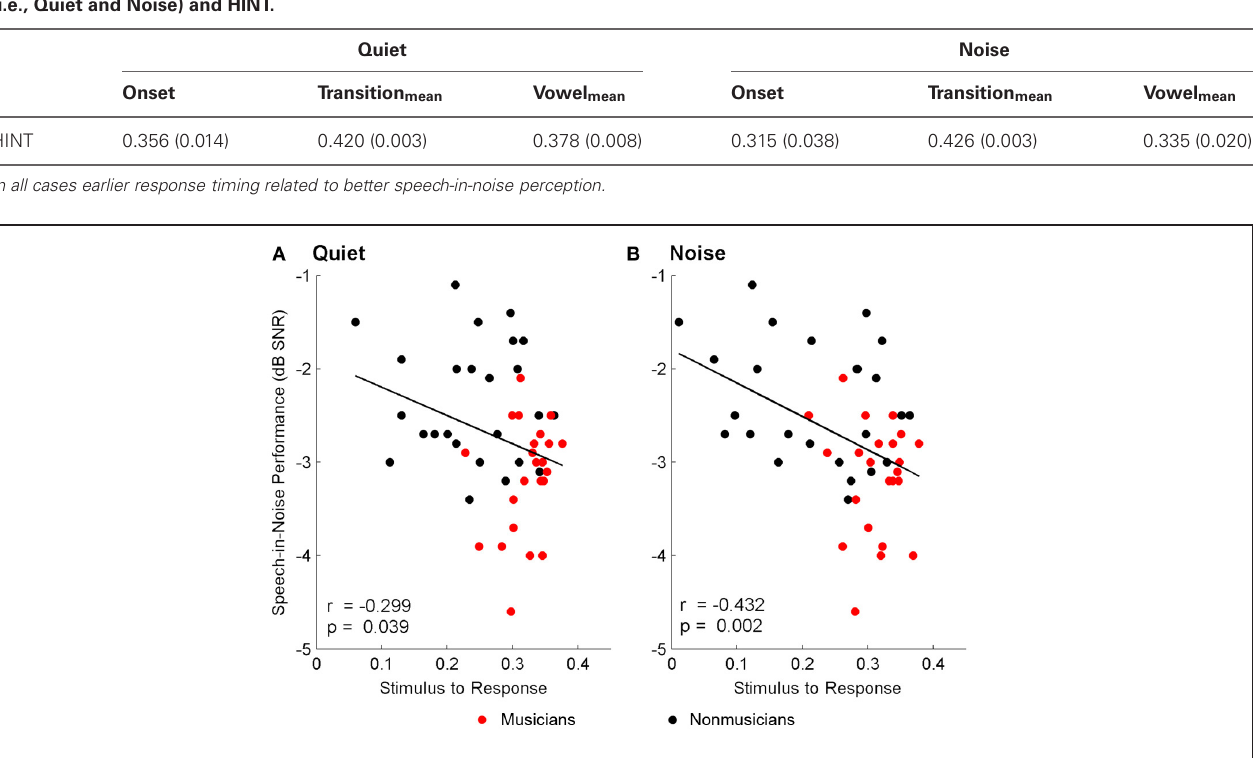
FIGURE 6 | Relationships between speech-in-noise performance and stimulus-to-response waveform (i.e., vowel) correlations. Better hearing in noise was associated with higher stimulus-to-response correlations in quiet (A) and noise (B) , suggesting that greater